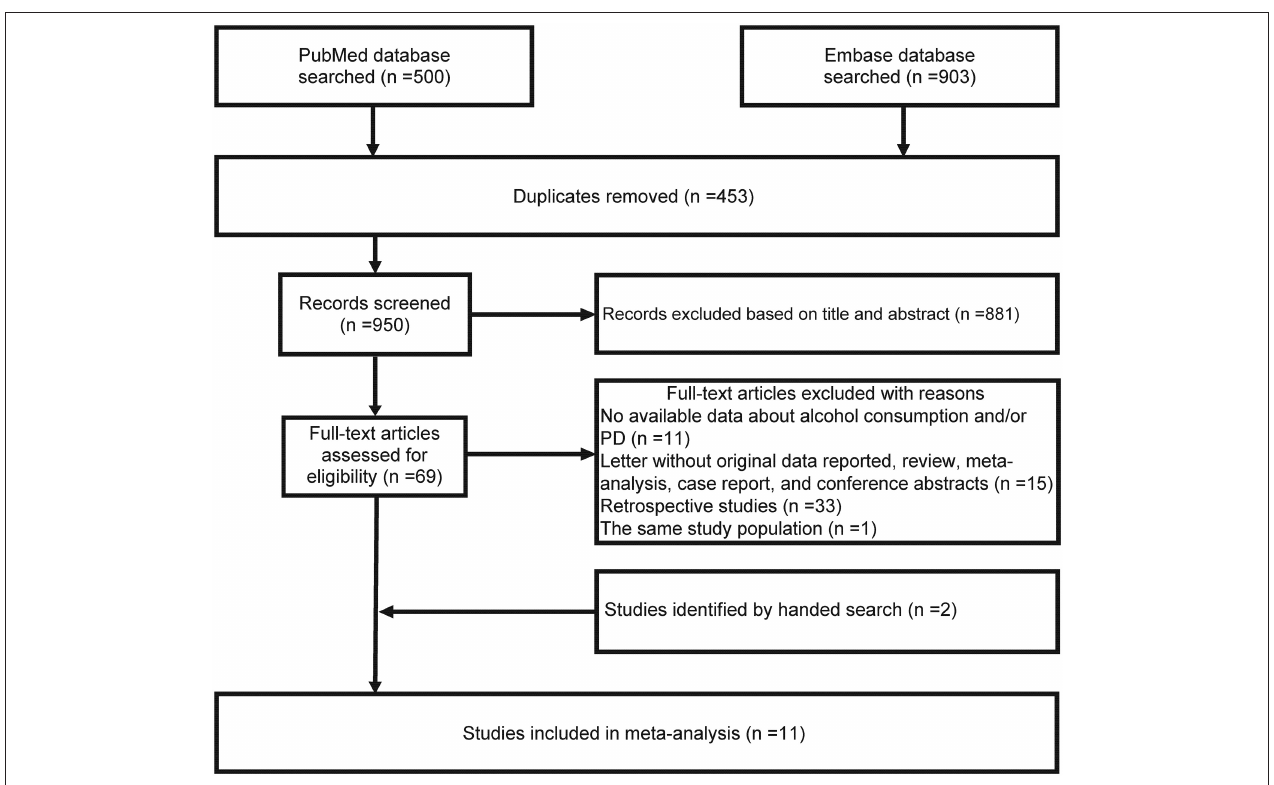
FIGURE 1 | Flowchart for the article selection